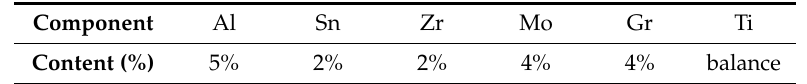
Table 1. Material composition.